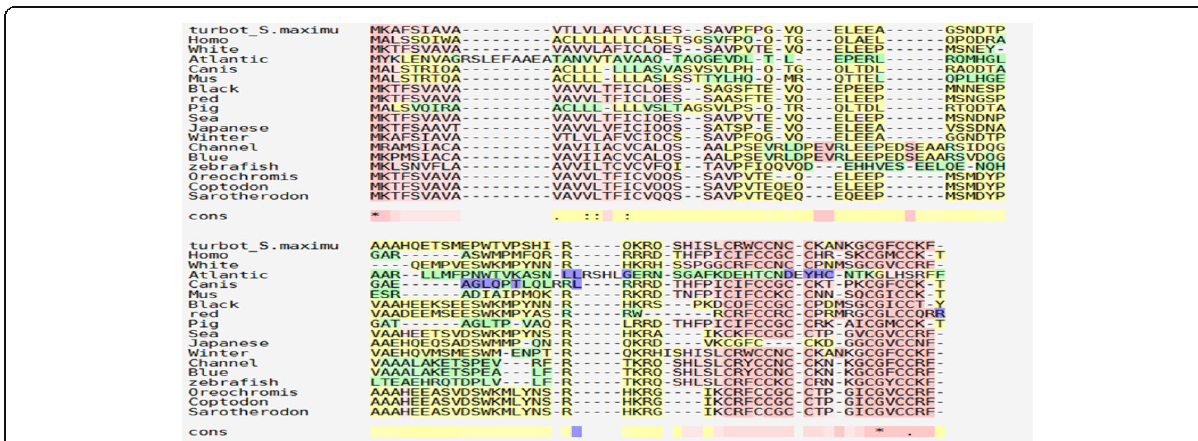
Fig. 8 Alignment of deduced amino acid sequences of O. niloticus , T. zillii , and S. galilaeus hepcidin 2 gene with those of turbot_S.maximus (AY994074), Homo sapiens (BC020612), white bass (AAM28440), Atlantic salmon (BI468191), Canis lupus familiaris (AY899807), mus musculus (BC021587), black seabream (AAU00801), red seabream (AAR28076), pig (NP_999282), sea perch (AAT09138), Japanese flounder (BAE06234), winter